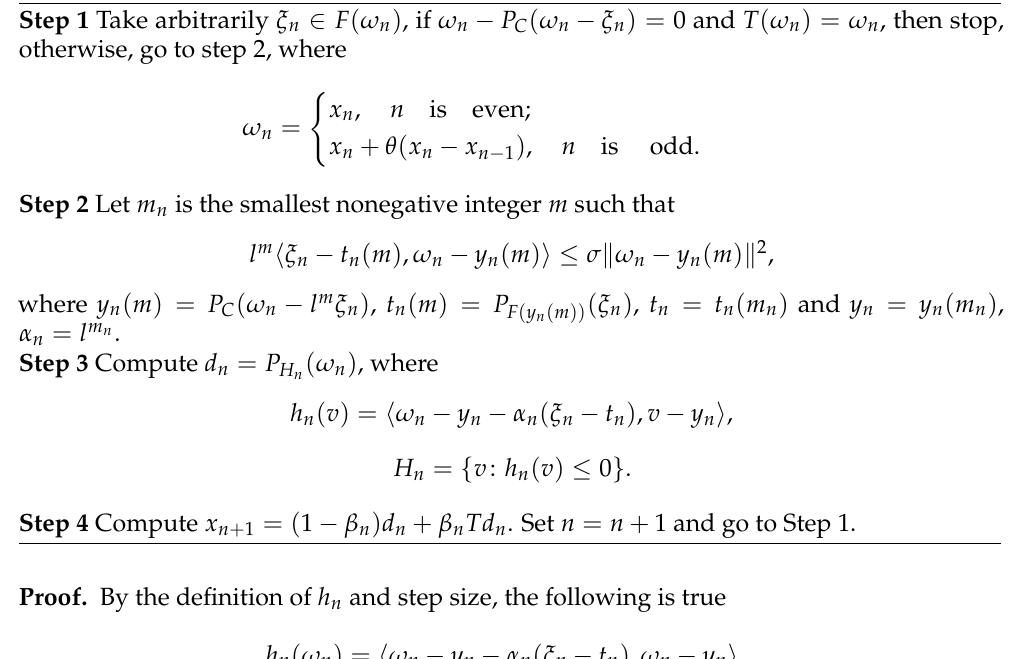
Algorithm 1 Choose parameters σ , l ∈ ( 0, 1 ) , x 0 , x 1 ∈ C as initial